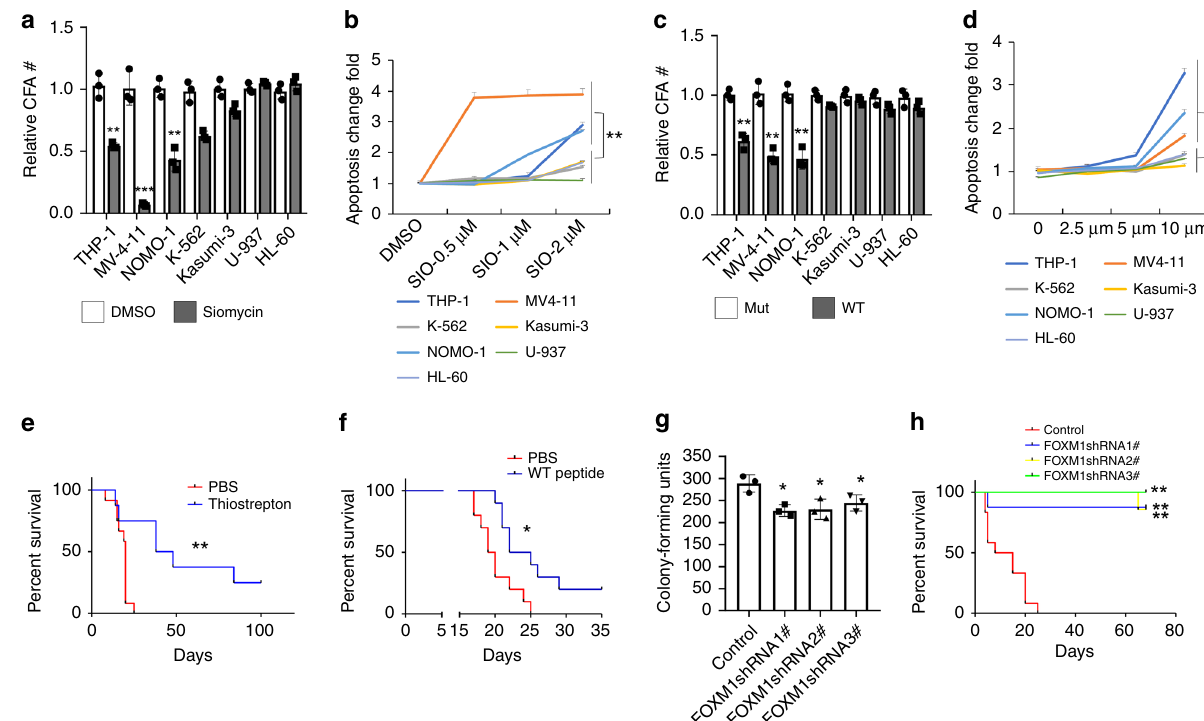
Fig. 7 Inhibition of FOXM1 suppressed MLL-r-induced leukemogenesis. a , b Relative colony-forming units ( a ) and frequency of apoptosis ( b ) of leukemia cells treated with DMSO or 1 μ M Siomycin A. MV4-11 and THP-1 and NOMO-1cell lines express MLL fusion genes while K-562, Kasumi-3, HL-60, and U- 937 cells do not express MLL-fusion genes. c , d Relative colony-forming units ( c ) and frequency of apoptosis ( d ) of leukemia cells treated with WT FOXM1-speci fi c ARF26-44 peptide or mutant ARF37 – 44 peptide. For colony-forming assay, the cells grew in Methocult TM medium containing 2 μ M Siomycine, DMSO, 10 μ M Foxm1-peptide or mutant peptide for 7 days. The apoptosis frequencies ( b ) were presented relative to those of cells treated with DMSO. The apoptosis frequencies ( d ) were normalized to those of cells treated with mutant peptide at each concentration and presented relative to